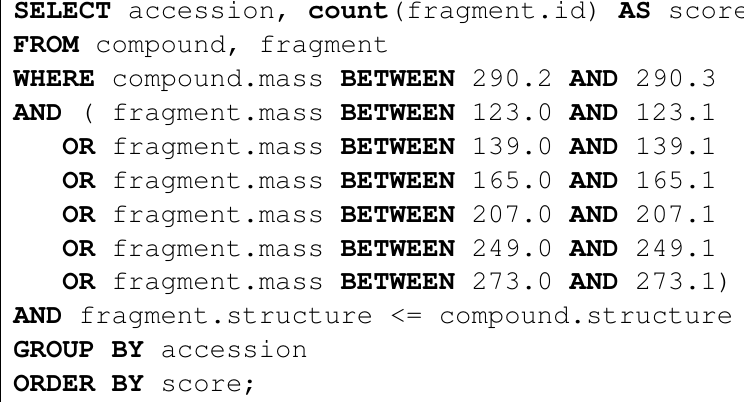
Figure 3: A SQL statement performing a combined search for the molecule’s mass , and fragments which are a substructure (the <= predicate) ranked by score , where <= is the chemical substructure operator. The peak data corresponds to the example spectrum in Figure